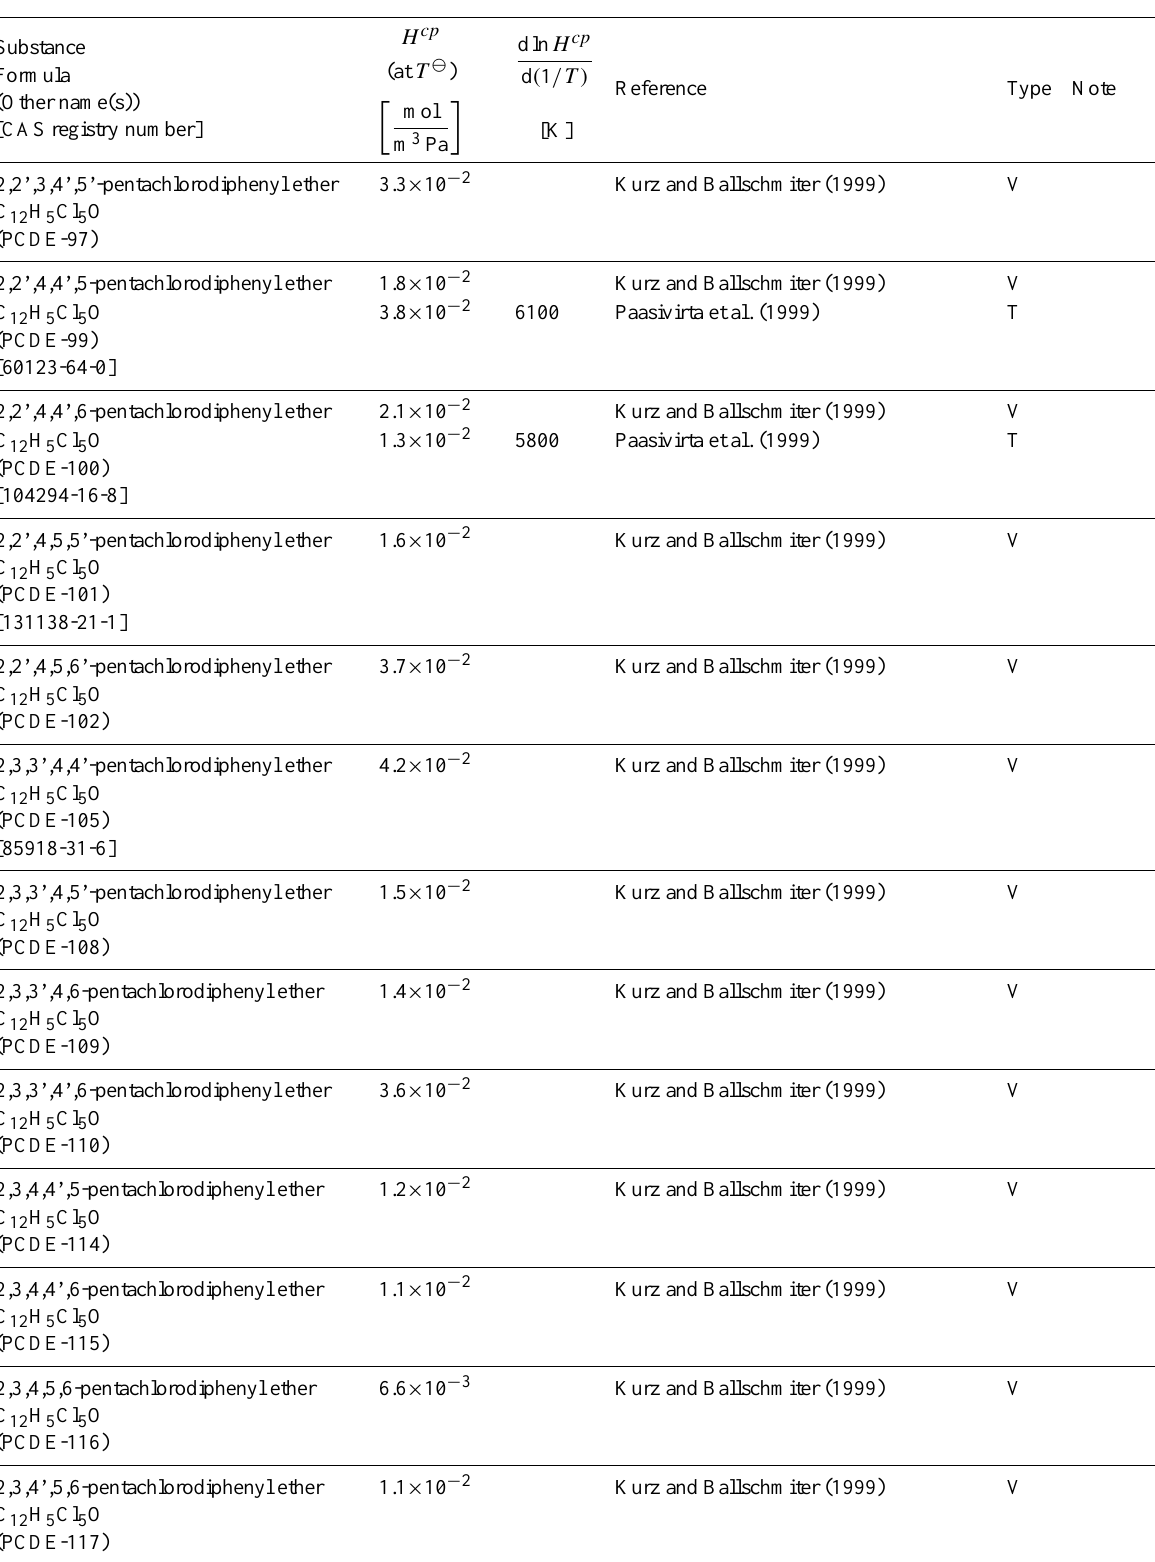
Table 6: Henry’s law constants for water as solvent